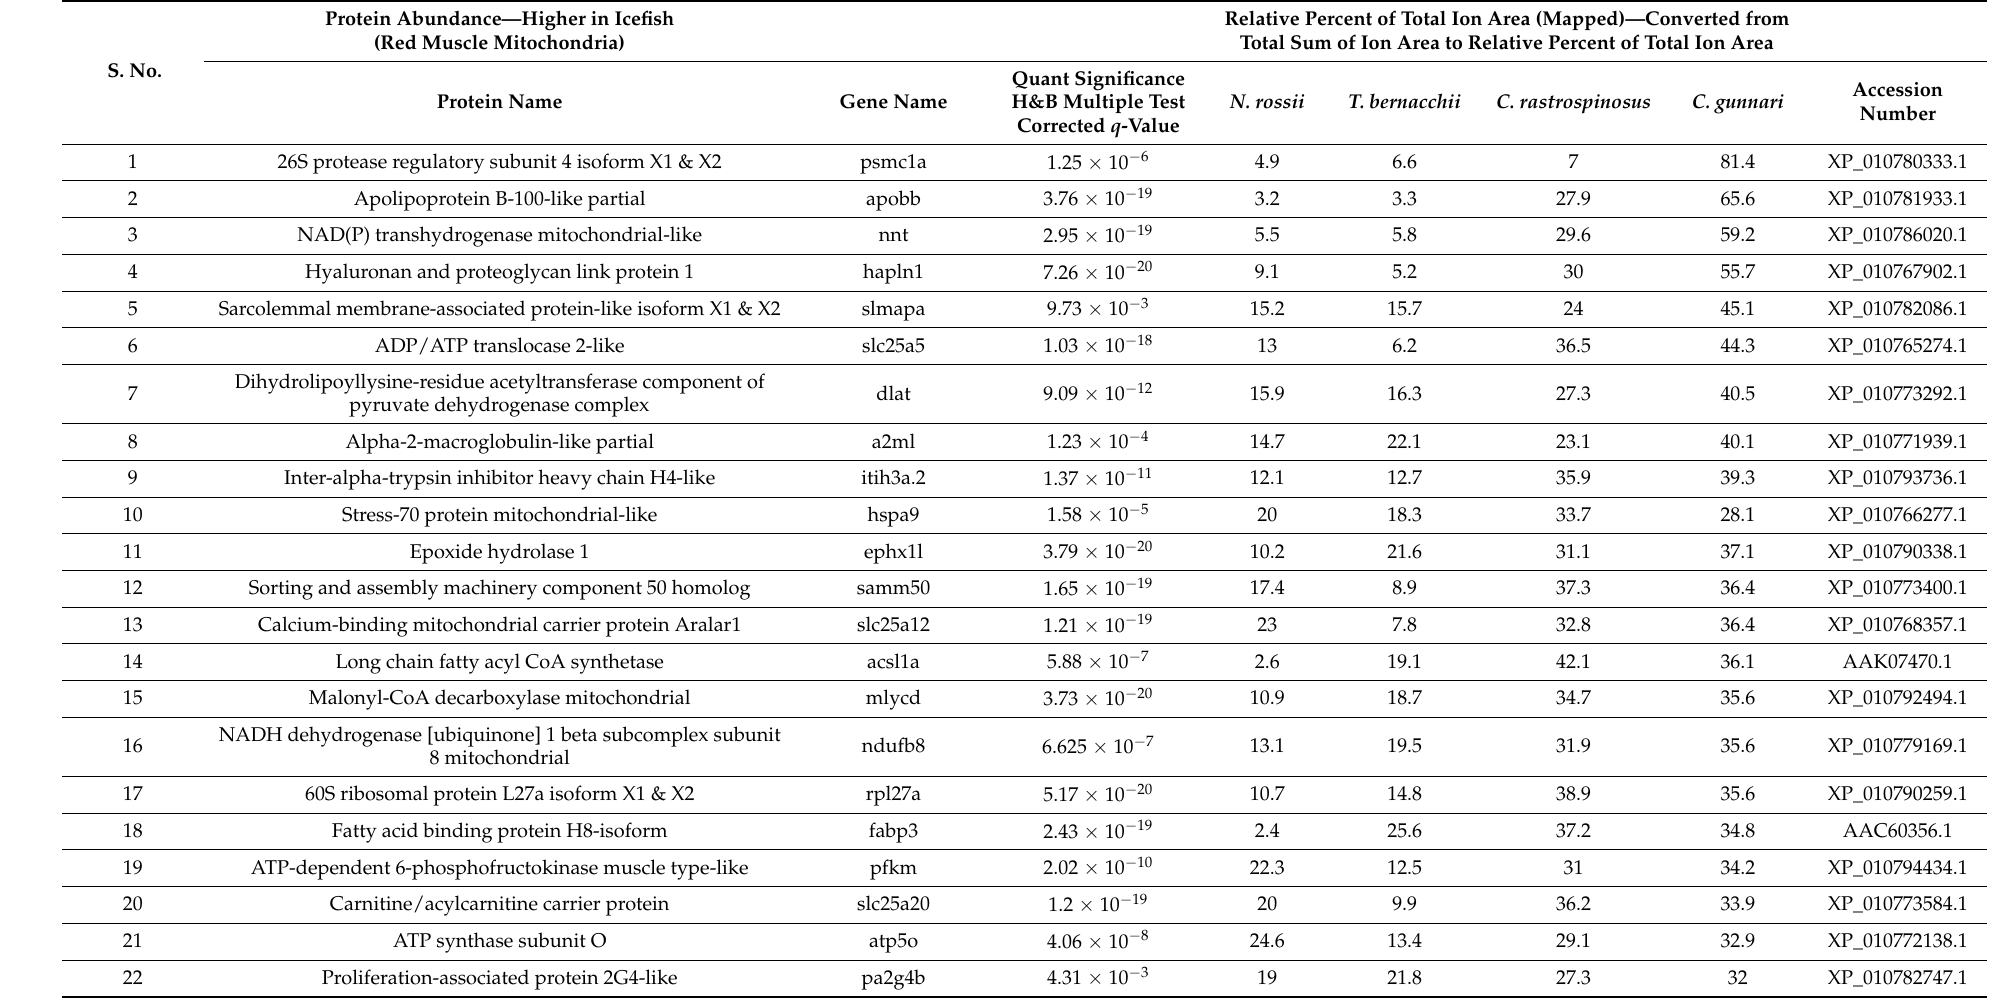
Table 1. Differentially expressed proteins (DEPs) among the four species in RMM—higher abundance in icefish. Protein Abundance—Higher in Icefish (Red Muscle S. No.